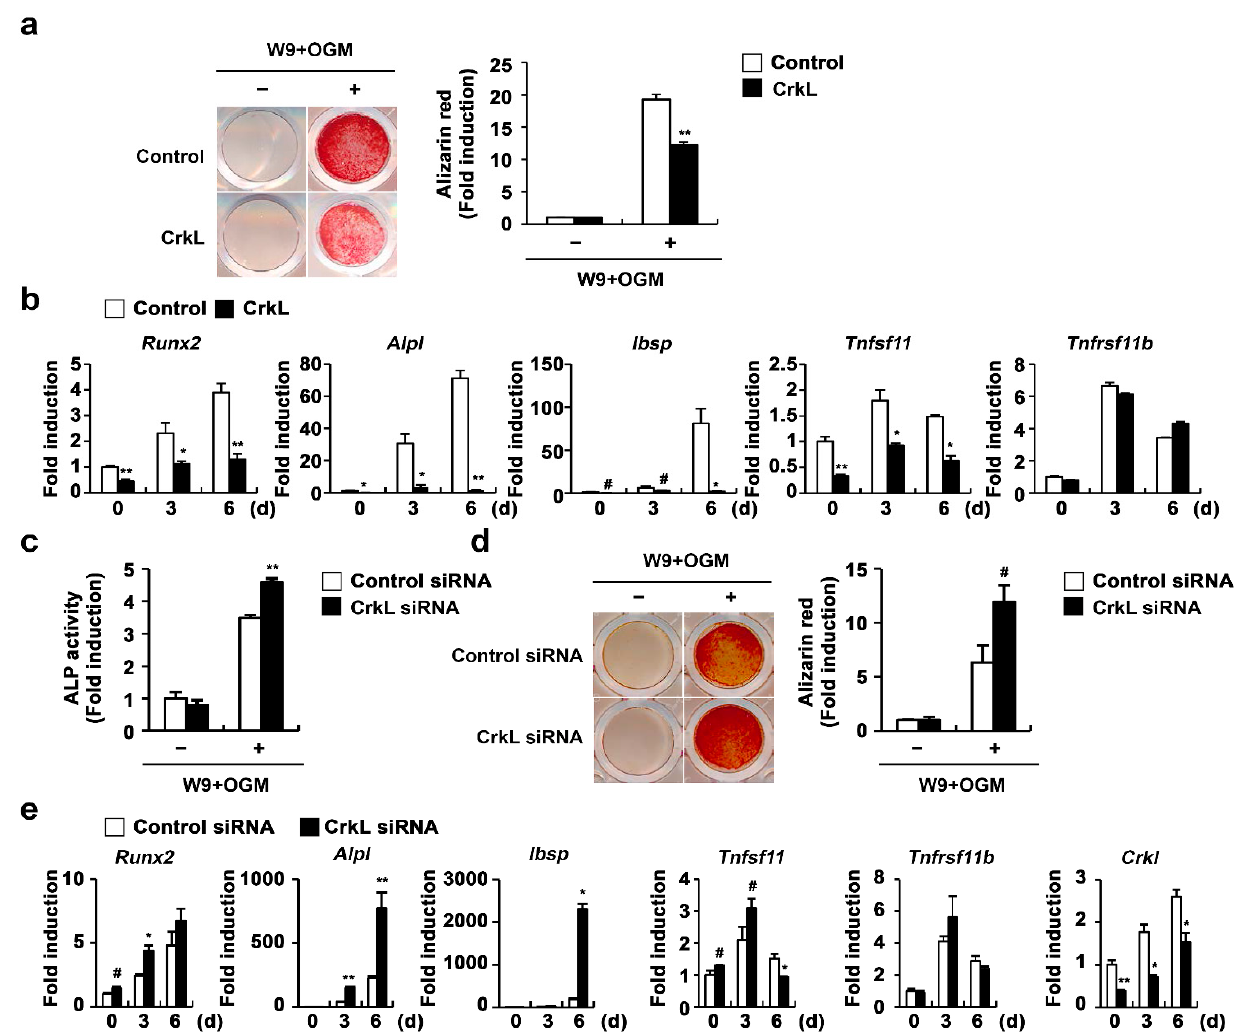
Figure 3. CrkL inhibits RANKL–RANK reverse signaling pathway. ( a , b ) Primary osteoblast precursors overexpressing the control or CrkL retrovirus were cultured in OGM supplemented with W9. ( a ) Alizarin red staining images (left panel) allowed for the quantification of the alizarin red staining intensities (right panel) under each condition. ( b ) mRNA expression of the indicated genes. ( c – e ) Primary osteoblast precursors transfected with control or CrkL siRNAs were cultured in OGM with W9. ( c ) ALP activity assay. ( d ) Alizarin red staining images (left panel). Quantification of alizarin red staining intensities (right panel). ( e ) mRNA expression of the indicated genes. # p < 0.05; * p < 0.01; ** p < 0.001 as compared with the controls.